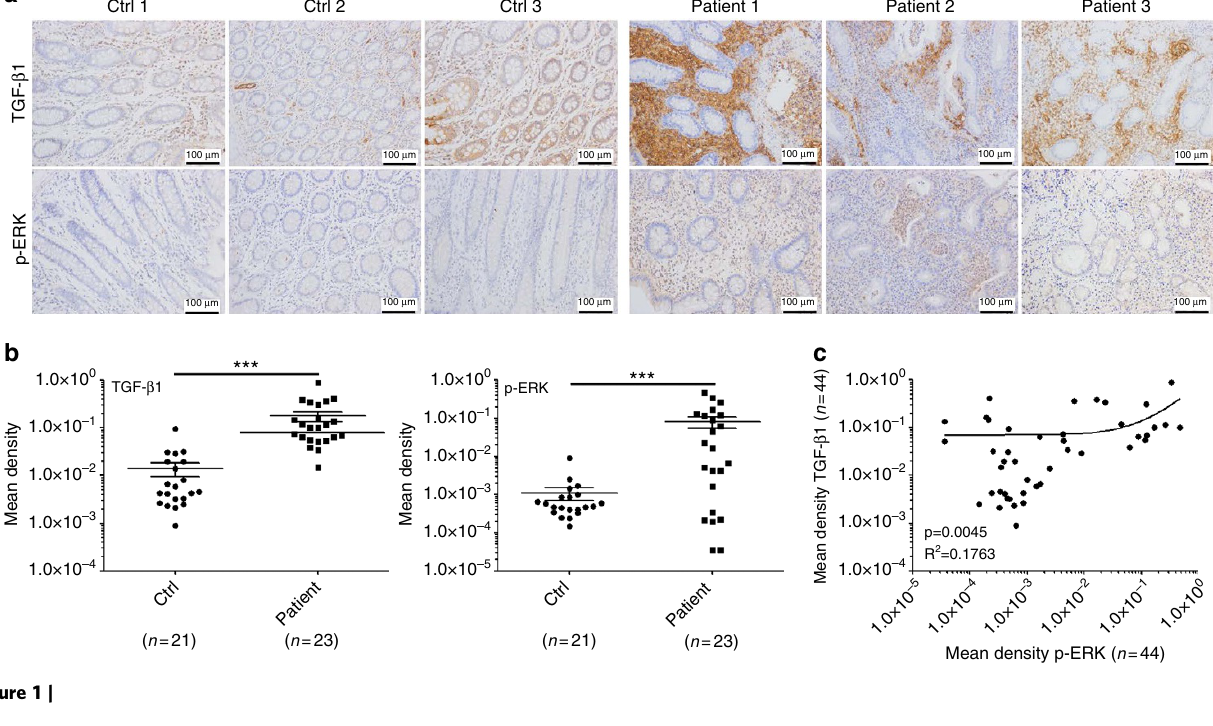
NATURE COMMUNICATIONS|8:16006|DOI: